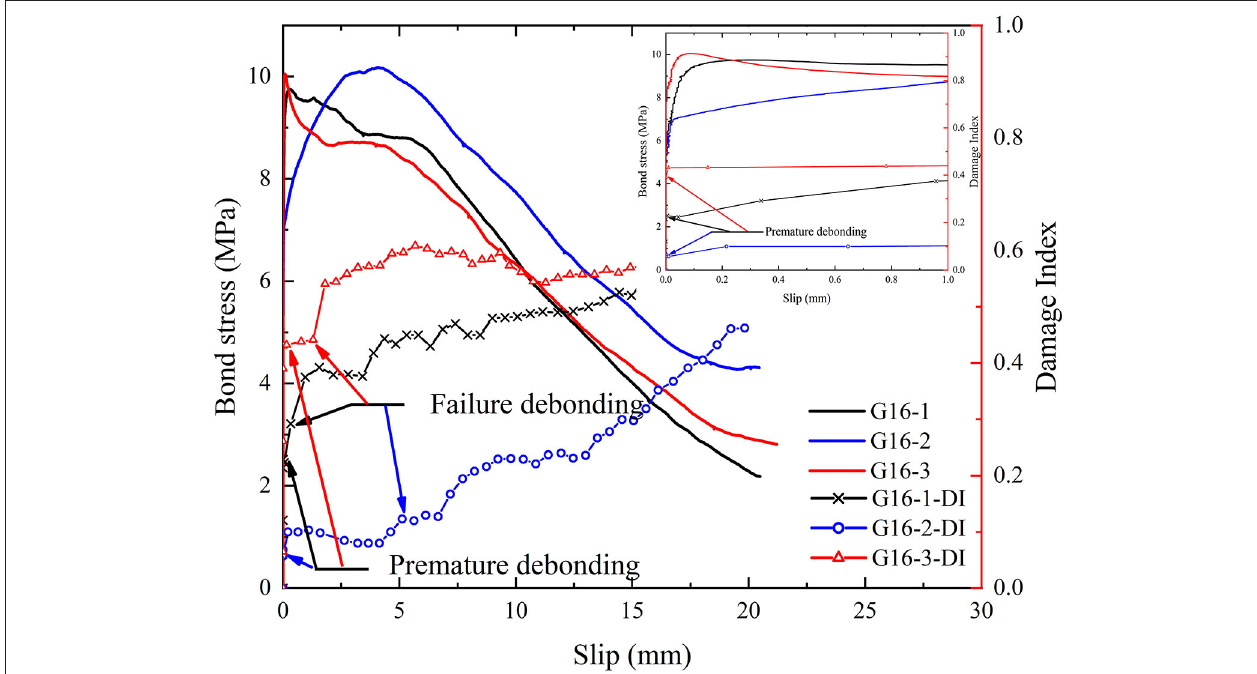
FIGURE 12 | Damage Index and bond-slip curves of G16.